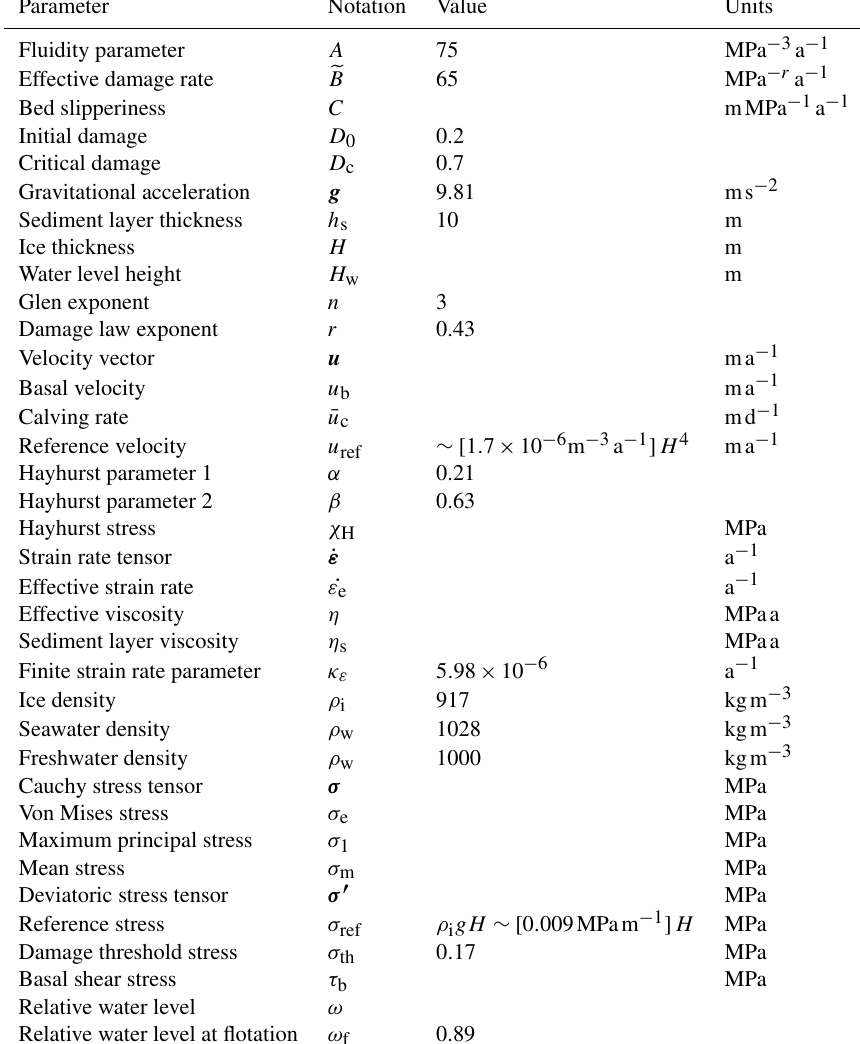
Table 1. Model parameters, notations, units and values for constant